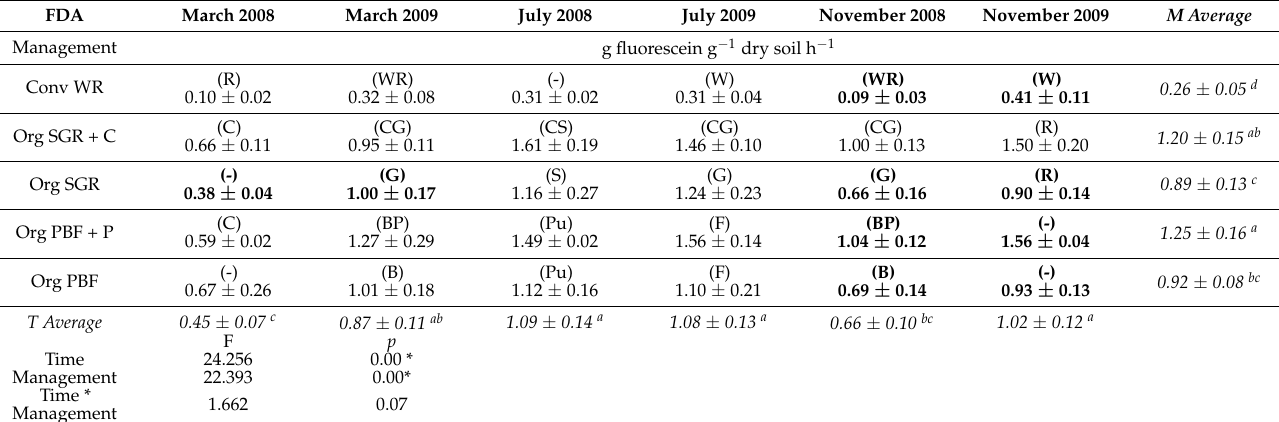
Table 11. Total microbial enzymatic activity measured by fluorescein diacetate hydrolase (FDA) activity in